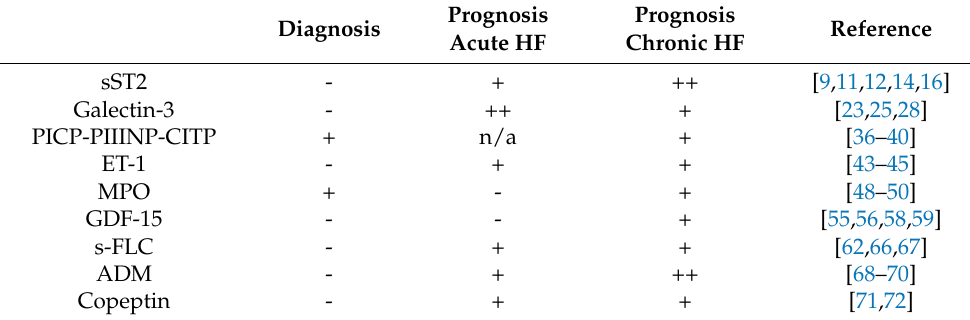
Figure 1. Pathophysiological pathways in heart failure and involved biomarkers. sST2 = soluble source of tumorogenesis-2; Gal-3 = galectin-3; PICP = serum carboxy-terminal propeptide of procollagen type I; PIIINP = serum amino-terminal propeptide of procollagen type III; CITP = serum collagen type I telopeptide; ET-1 = endothelin-1; MPO= Myeloperoxidase; GDF15 = Growth-differentiation factor-15; s-FLC = serum free light chain; ADM = adrenomedullin. Table 1. Clinical role of the novel biomarkers of inflammation and fibrosis in